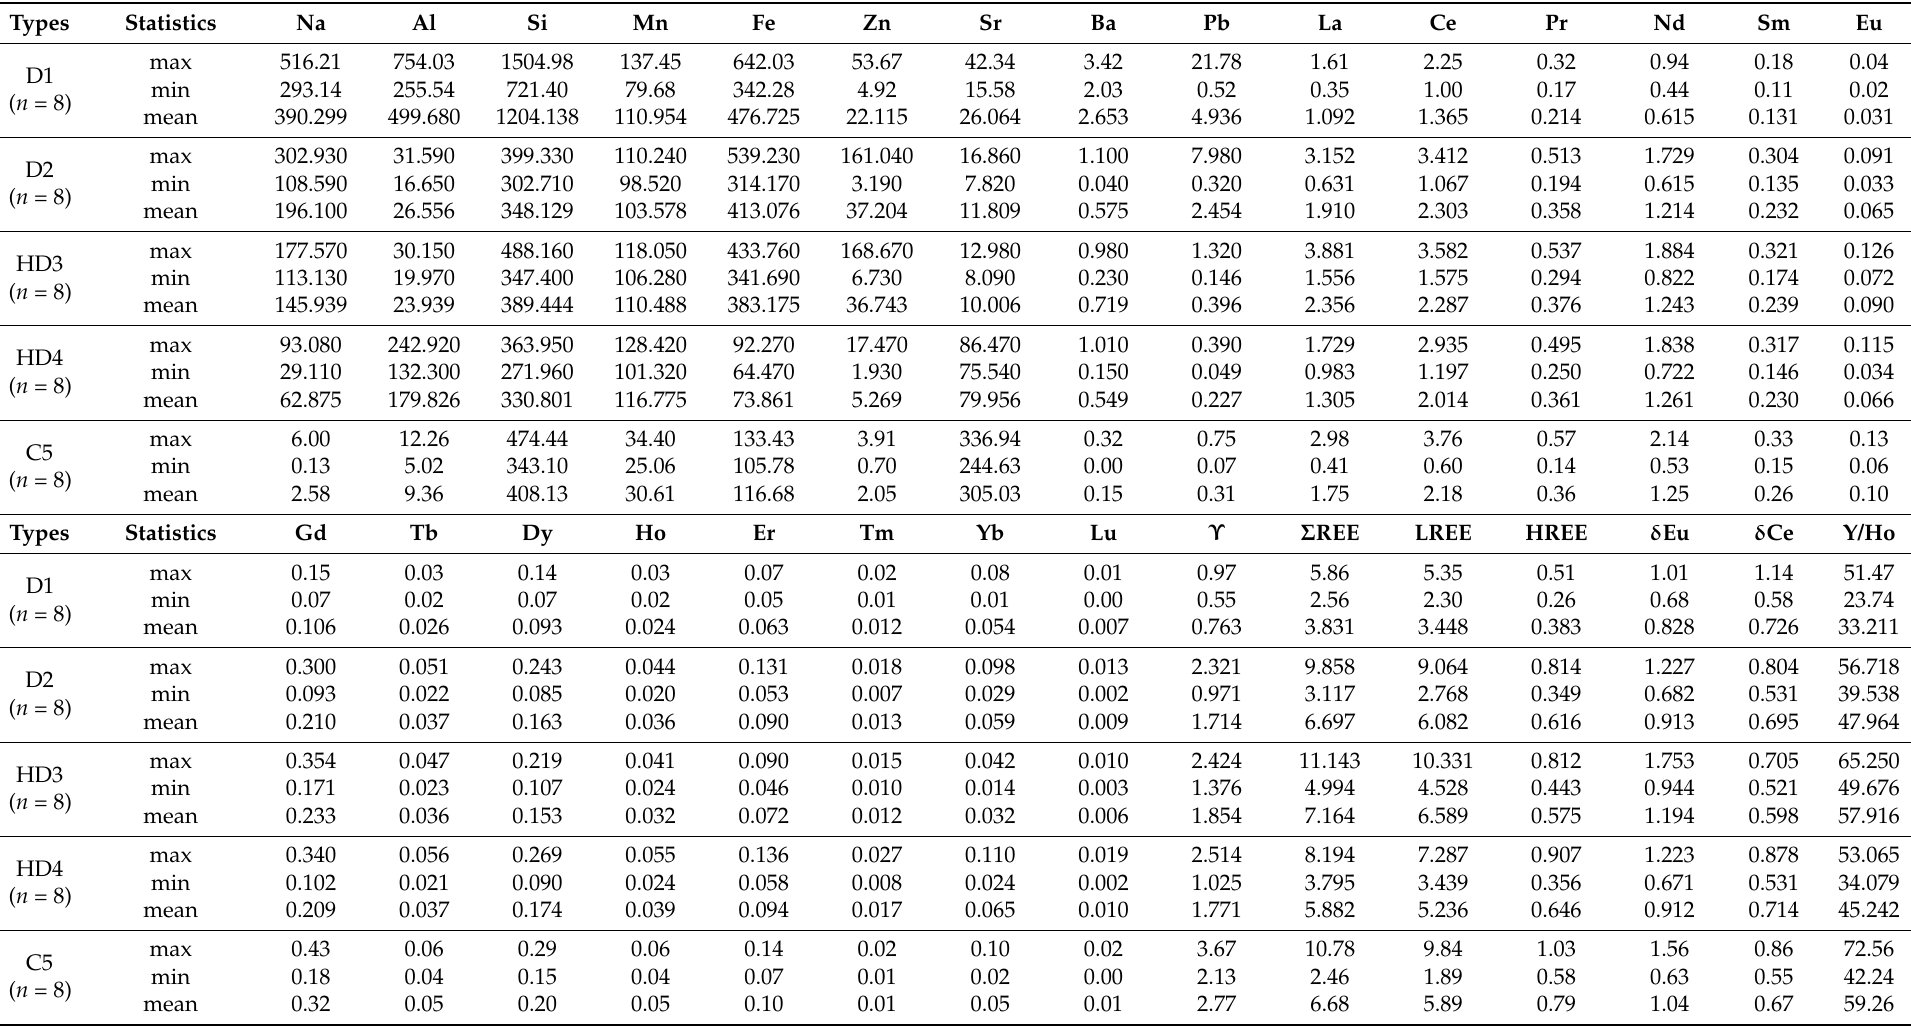
Table 1. Summary of LA-ICP MS carbonate trace element concentration (ppm) in the Fuli Pb-Zn